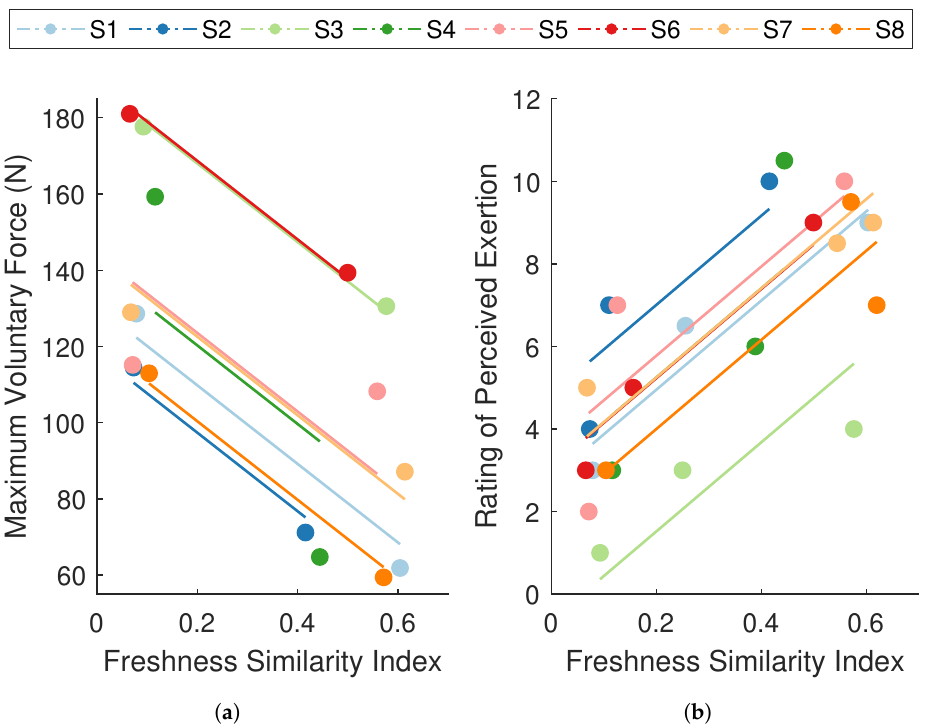
Figure 7. Repeated measures correlations between the freshness similarity index (FSI) and ( a ) maximum voluntary contraction (MVC) force and ( b ) ratings of perceived exertion (RPE). Data points are grouped by participant ( n = 8), where each color summarizes all observations from one participant and corresponding lines represent the rmcorr fit for that participant. Participant color assignments are consistent with those in other figures. FSI revealed a strong, negative relationship with MVC force ( r rm = − 0.86, p < 0.01) and a strong, positive relationship with RPE ( r rm = 0.87, p <